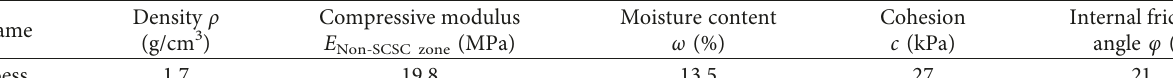
Table 5: Physical properties of loess.